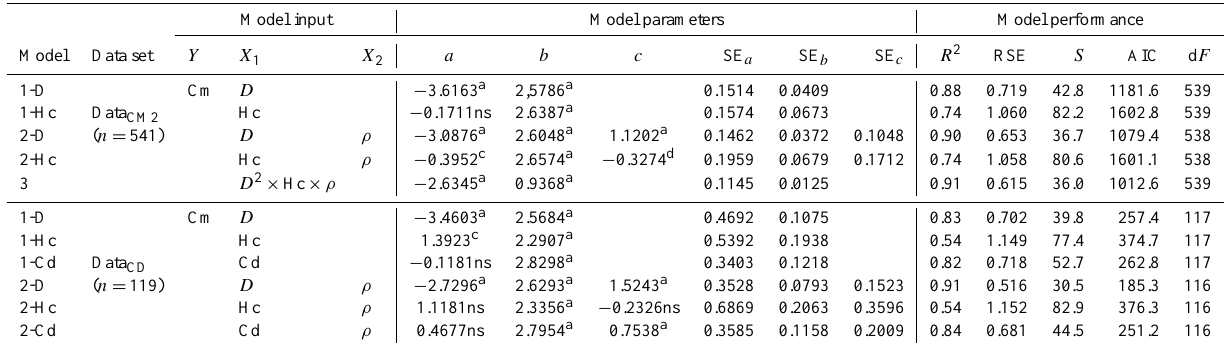
Table A1. Preliminary crown mass sub-models. Model parameters are D (diameter at breast height,cm), Hc (crown depth, m), Cm (crown mass, kg), Cd (crown diameter, in m), Cs (average of Hc and Cd, m) and ρ (wood density, gcm − 3 ) . The general form of the models is ln( Y) = a + b × ln (X 1 ) + c × ln (X 2 ) . Model coefficient estimates are provided along with the associated standard error is denoted by SE i , with i as the coefficient.